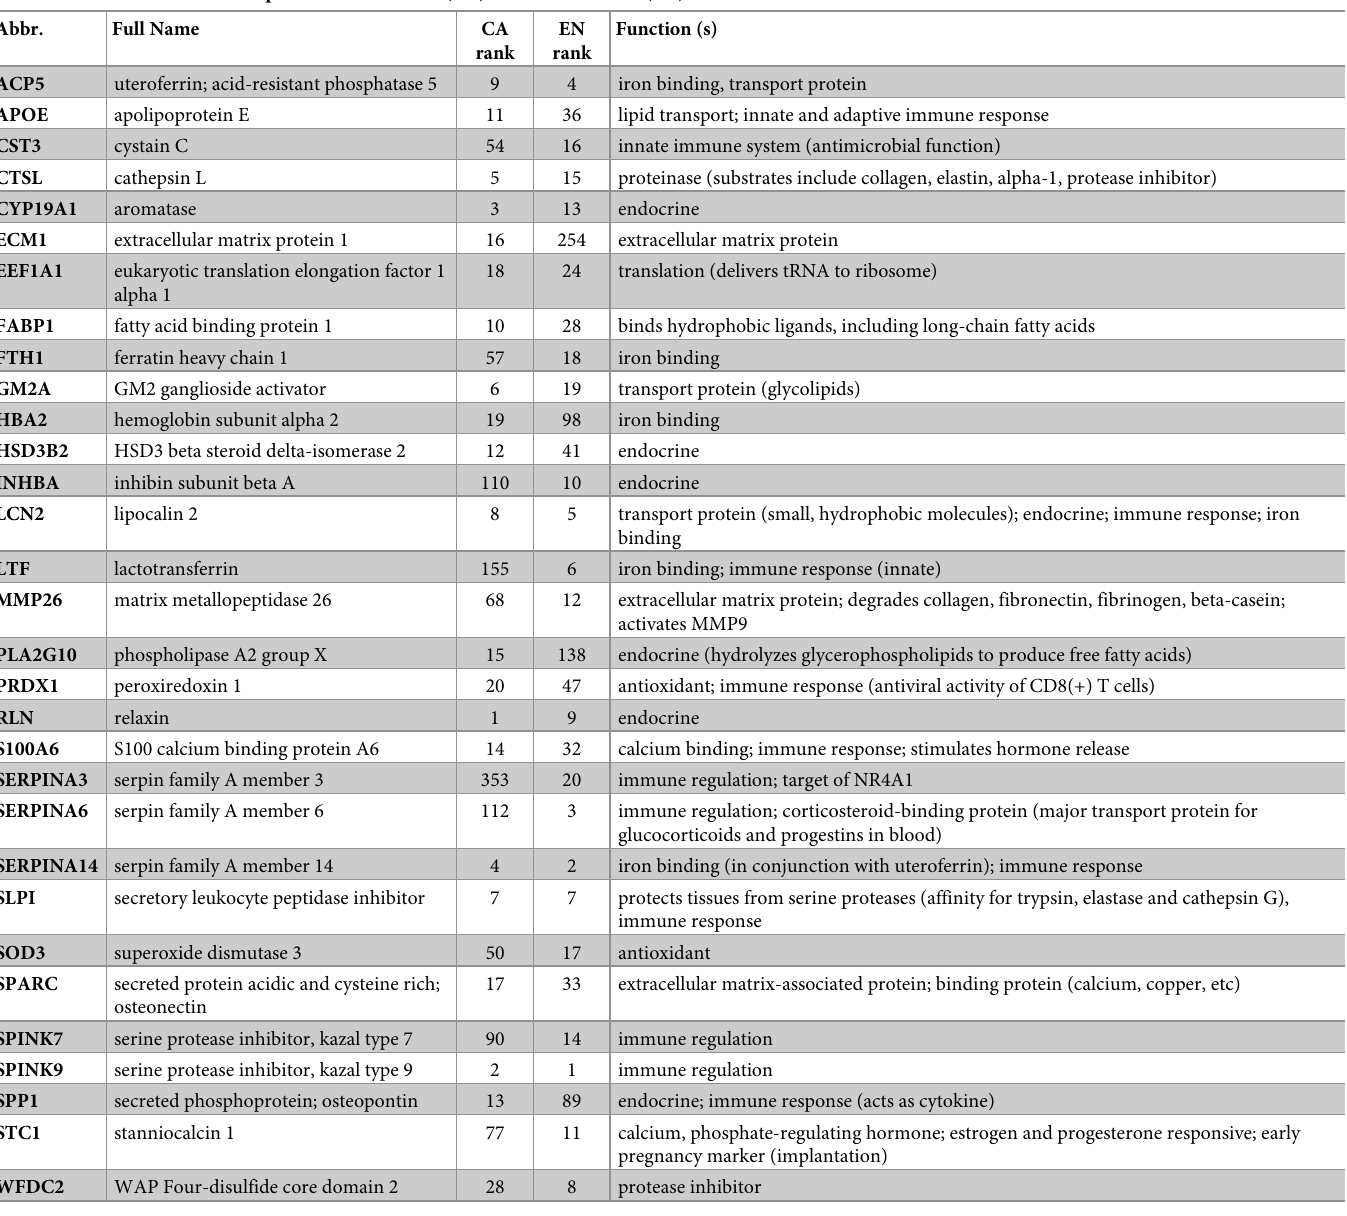
Rank refers to relative abundance / tissue; rank 1 is transcript with the highest average abundance across gestation. Abundance determined by averaging all samples by time point (n = 4), then using the highest average value across gestation for